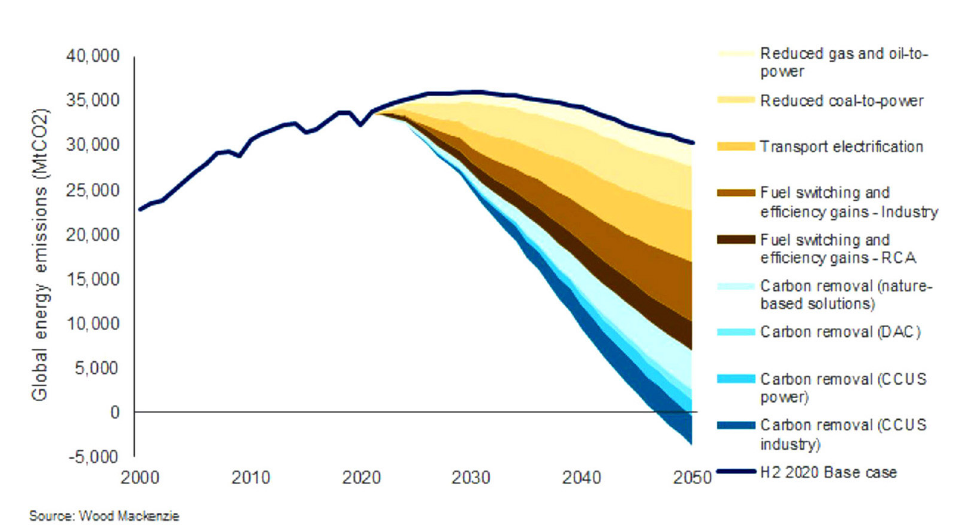
Fig. 2. – Change in global CO 2 emissions needed to reach net zero by 2050 [1].